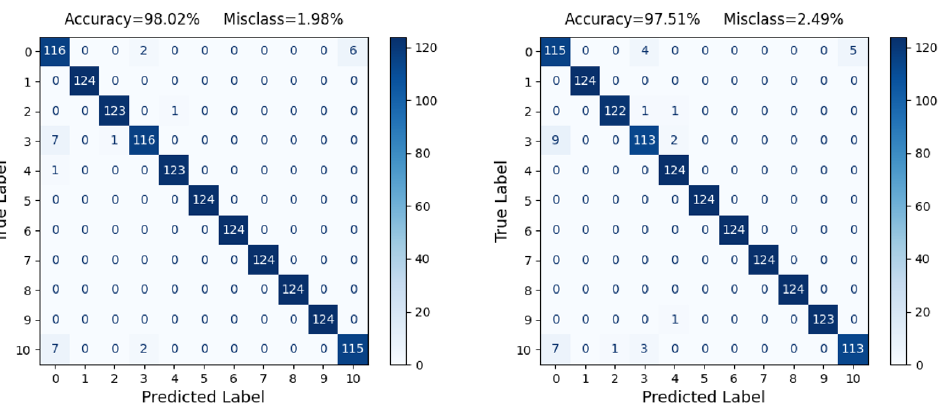
Figure 13. Confusion matrix for the Soli 50–50% split for training and evaluation. Results for an LSM with 460 neurons, C inp = 25 and using SVM classifier. Left table shows the results for normalized S l and the right for variable S l